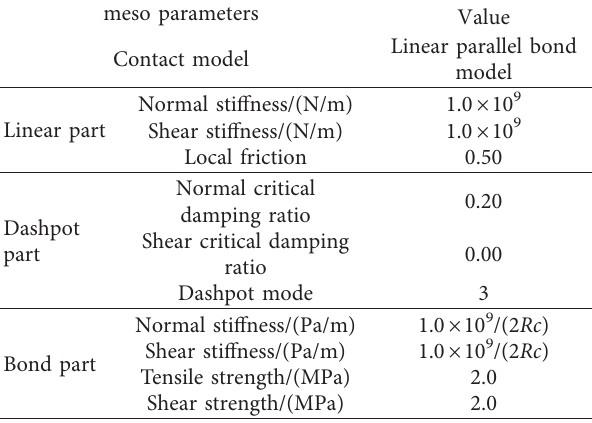
Table 6: Microproperties of PBM contacts between subparticles.